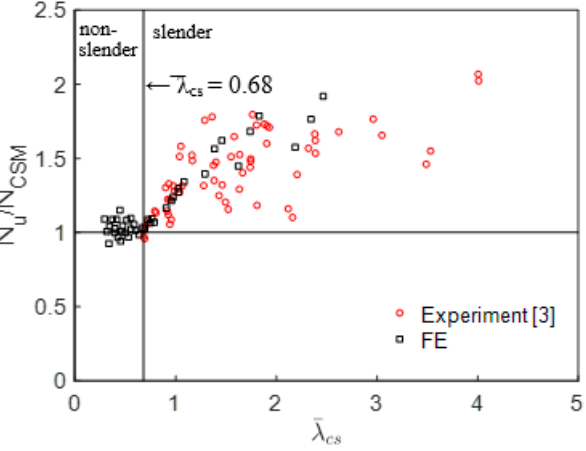
Figure 12. Assessment of CSM design strength predictions.